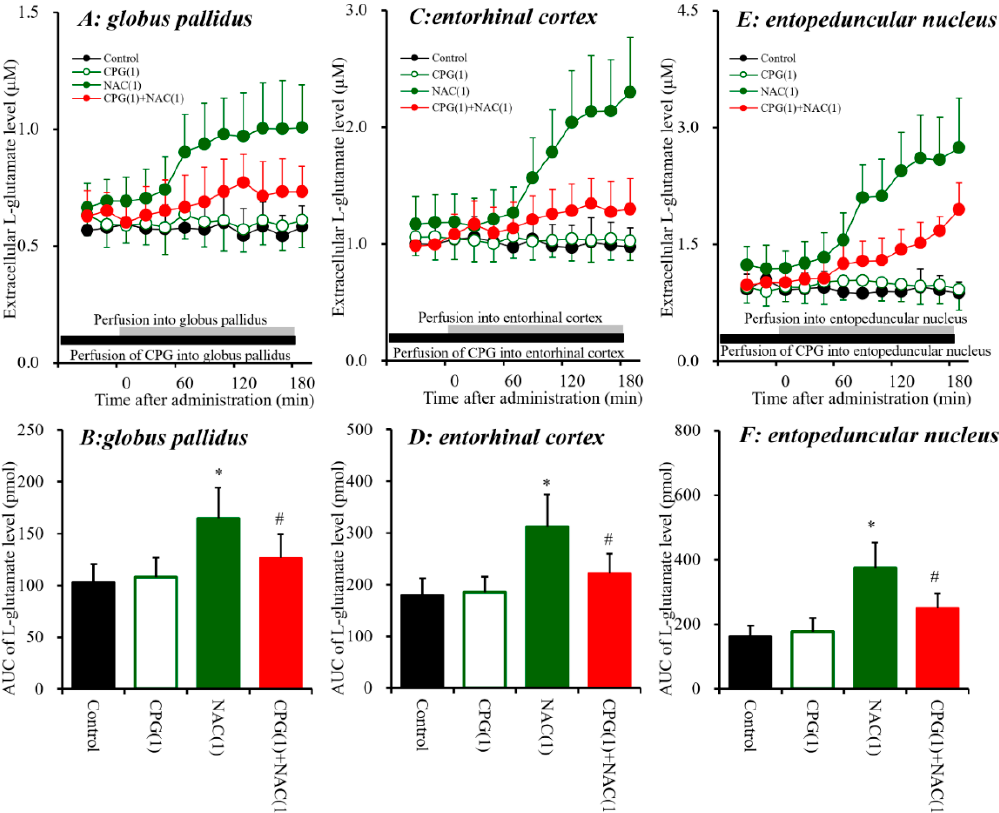
Figure2. EffectsoflocaladministrationofN-acetyl-L-cysteine(NAC)(1mM)and(S)-4-carboxyphenylglycine Figure 2. Effects of local administration of N-acetyl-L-cysteine (NAC) (1 mM) and (CPG) (1 µ M) into the globus pallidus, entorhinal cortex and entopeduncular nucleus on the (S)-4-carboxyphenylglycine (CPG) (1 μ M) into the globus pallidus, entorhinal cortex and respective extracellular L-glutamate levels in the globus pallidus ( A , B ), entorhinal cortex ( C , D ), entopeduncular nucleus on the respective extracellular L-glutamate levels in the globus pallidus and entopeduncular nucleus ( E , F ). ( A , C , E ) indicate the e ff ects of perfusion with NAC and CPG into the ( A , B ), entorhinal cortex ( C , D ), and entopeduncular nucleus ( E , F ). ( A , C , E ) indicate the effects of globus pallidus, entorhinal cortex and entopeduncular nucleus on extracellular L-glutamate levels, perfusion with NAC and CPG into the globus pallidus, entorhinal cortex and entopeduncular respectively. The initial perfusion medium was MRS. After the stabilization of L-glutamate levels in the nucleus on extracellular L-glutamate levels, respectively. The initial perfusion medium was MRS. perfusate, the perfusion medium was switched from MRS to MRS containing CPG (1 µ M) or NAC After the stabilization of L-glutamate levels in the perfusate, the perfusion medium was switched (1 mM) (gray bars). To determine the e ff ects of CPG on NAC-induced L-glutamate release, the initial from MRS to MRS containing CPG (1 μ M) or NAC (1 mM) (gray bars). To determine the effects of perfusion medium was MRS containing GPG (1 µ M) (black bars). After the stabilization of L-glutamate CPG on NAC-induced L-glutamate release, the initial perfusion medium was MRS containing GPG levels in the perfusate, the perfusate was switched to MRS containing CPG (1 µ M) plus NAC (1 mM) (1 μ M) (black bars). After the stabilization of L-glutamate levels in the perfusate, the perfusate was (gray bars). Ordinates: mean ± SD ( n = 6) of extracellular L-glutamate level ( µ M); abscissa: time after switched to MRS containing CPG (1 μ M) plus NAC (1 mM) (gray bars). Ordinates: mean ± SD ( n = administration of the target agent (min). ( B , D , F ) indicate the AUC values of extracellular L-glutamate 6) of extracellular L-glutamate level ( μ M); abscissa: time after administration of the target agent levels (pmol) after 20 to 180 min perfusion with the target agent in ( A , C , D ). * p < 0.05 relative to the (min). ( B , D , F ) indicate the AUC values of extracellular L-glutamate levels (pmol) after 20 to 180 min control, and # p < 0.05 relative to NAC by LME with Tukey’s post hoc perfusion with the target agent in ( A , C , D ). * p < 0.05 relative to the control, and # p < 0.05 relative to NAC by LME with Tukey’s post hoc test.